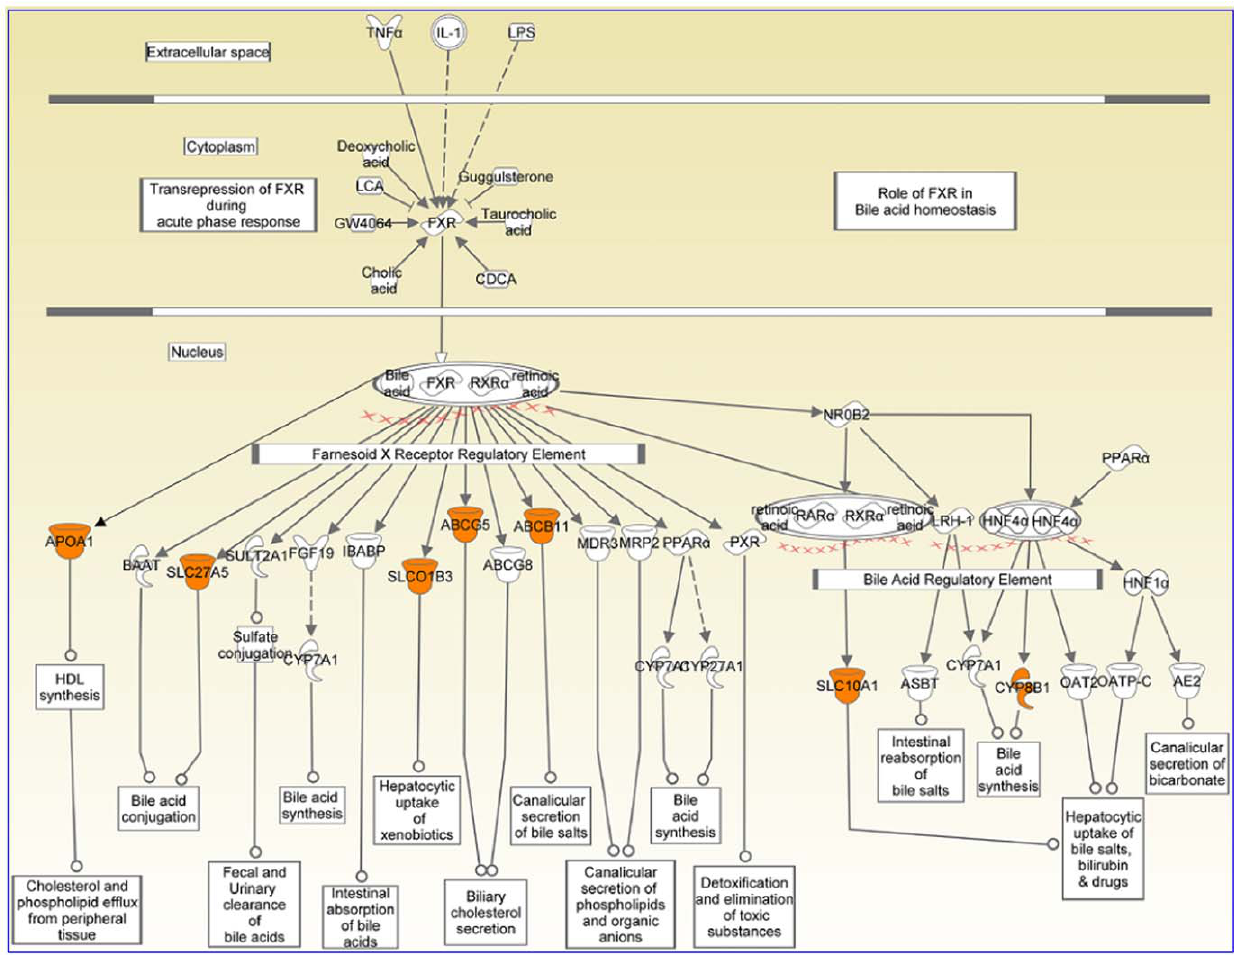
Figure 10. Liver genes enriched in FXR/RXR activation pathway IPA analysis of the top 100 probe-sets from the liver 1 cluster (Figure 7) showed the enrichment of FXR/RXR activation pathway. The genes present in this pathway are highlighted in orange. The liver genes present in the pathway are given in Table 9. Pathway diagram was drawn using Path Designer function of IPA [18].